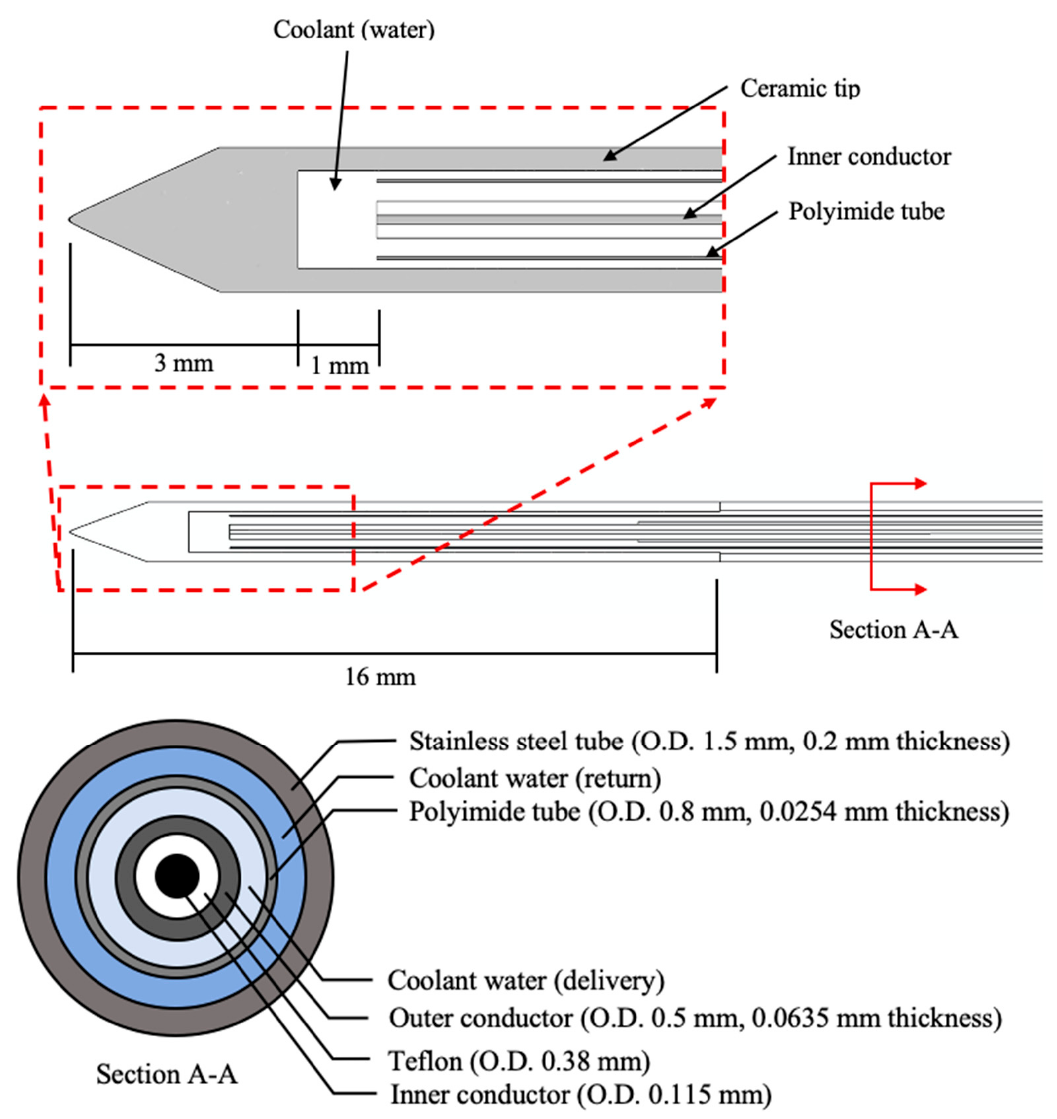
Figure 1. Schematic diagrams of the microwave probe.